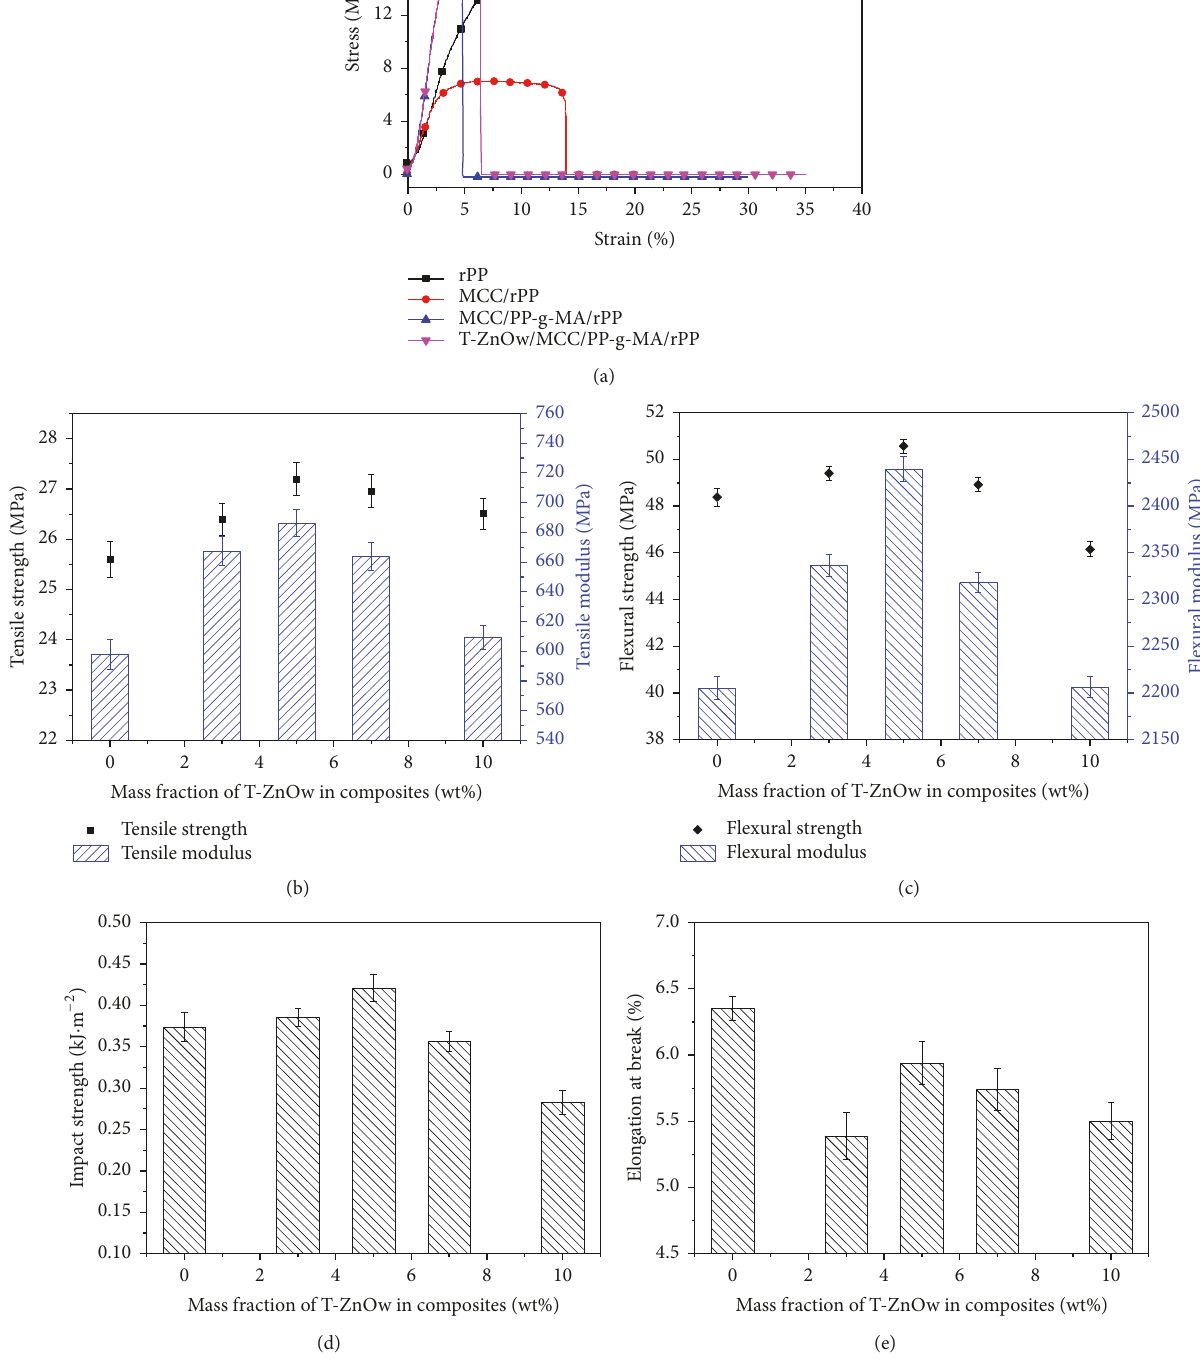
Figure 2: Stress-strain curves and influence of various T-ZnOw concentrations on the mechanical properties of T-ZnOw/MCC/PP-g- MA/rPP